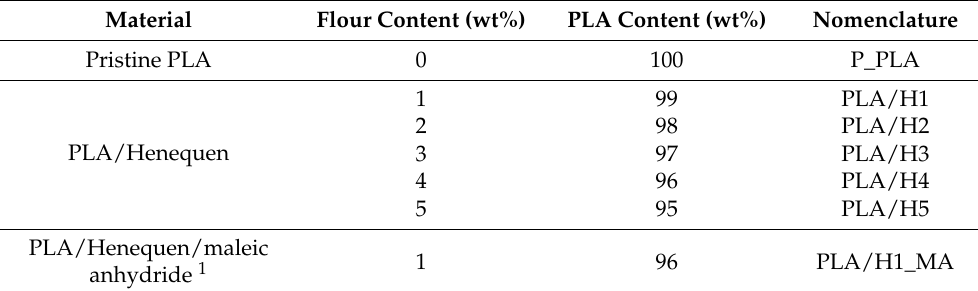
Table 1. Formulation of the filaments for 3D printing of PLA and NFRCs.